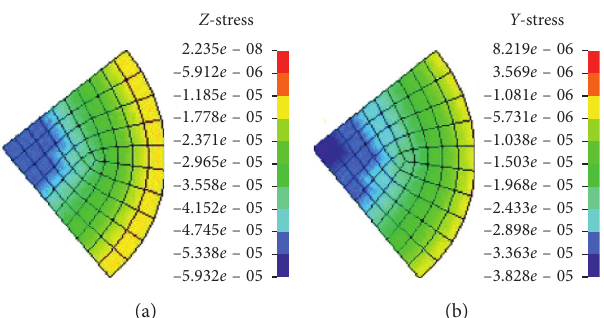
Figure 16: Distribution of the stress on the cross section at a velocity of 10 m/s: (a) axial stress and (b) radial